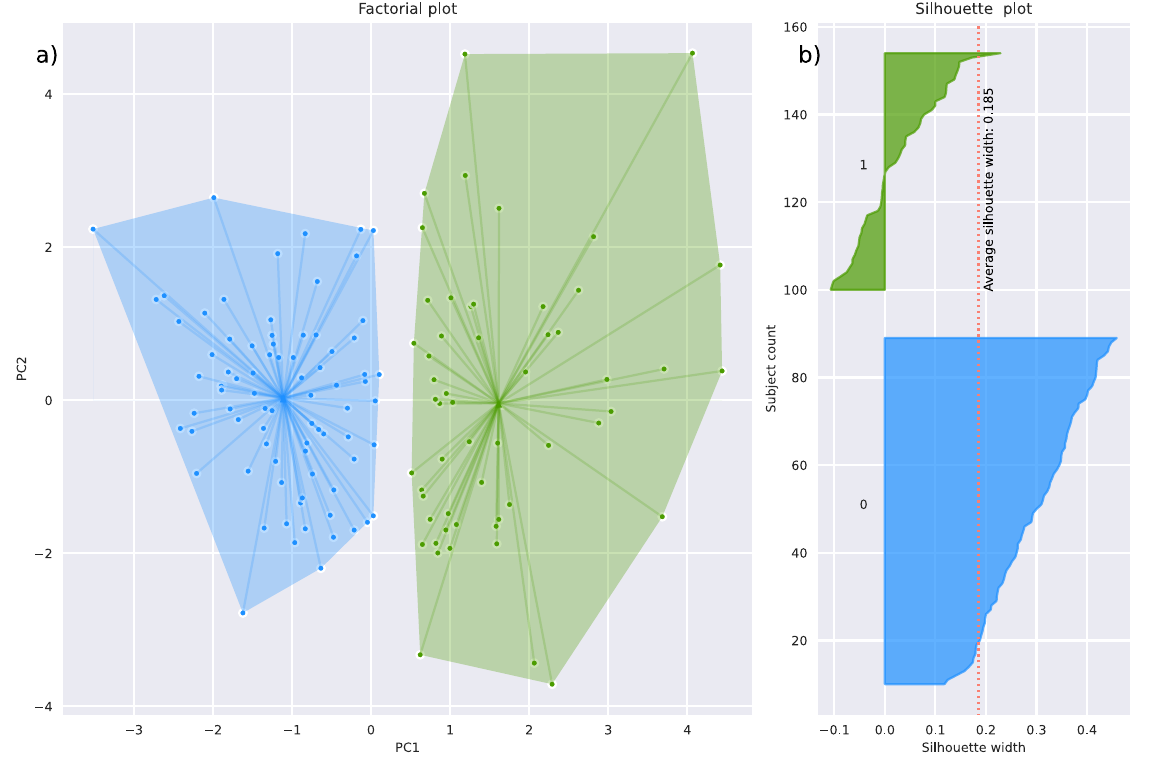
Figure 5. Clustering of the d = 15 olfaction-related parameters. ( a ) Factorial plot of the individual data points on a principal components map, obtained following k-means clustering. The colored areas visualize the cluster separation. The cluster members are connected by straight lines with their respective cluster centers. ( b ) Silhouette plot associated with the cluster solution presented in panel ( a ). The horizontal bars show the average distance of each data point in a cluster is to points in neighboring cluster(s), scaled in the range of [ − 1, 1] [48]. The figure has been created using Python version 3.8.12 for Linux (https://www.python.org, accessed on 28 January 2022) and Seaborn Python data visualization library (https://seaborn.pydata.org, accessed on 28 January 2022 [65] ).